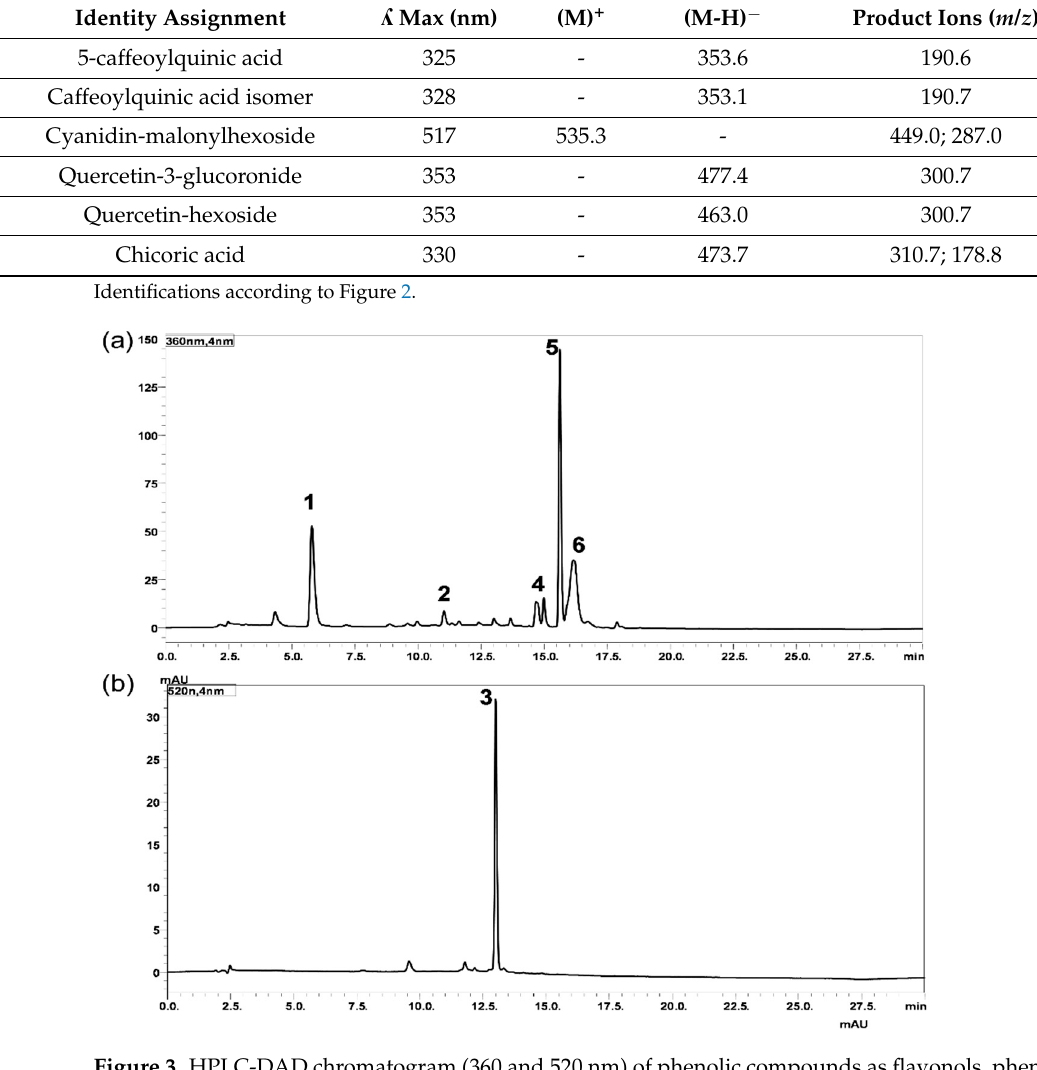
Figure 3. HPLC-DAD chromatogram (360 and 520 nm) of phenolic compounds as flavonols, phenolic acids ( a ) and anthocyanins ( b ) in lettuce leaves growing under saline conditions. Identifications are according to Table 1.